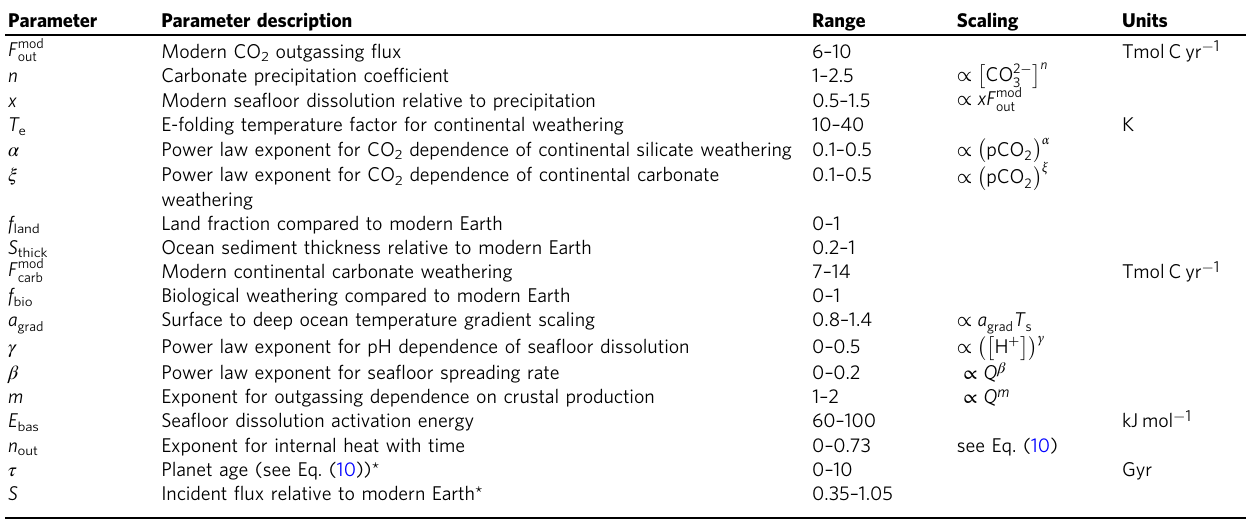
Table 1 Parameter ranges for our numerical